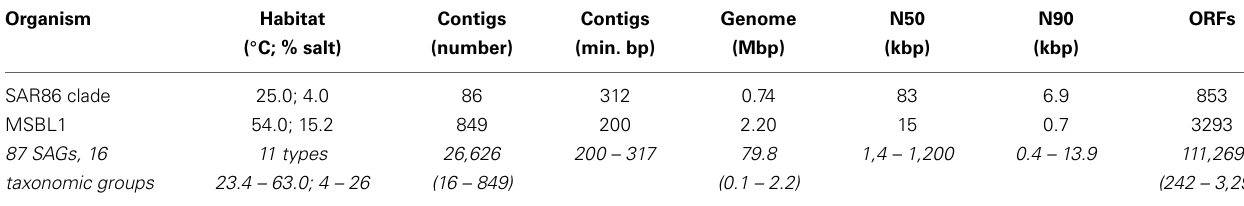
Table 1 | Two example and summary ( italic ) of the SAG data in INDIGO used for this work. Organism Habitat